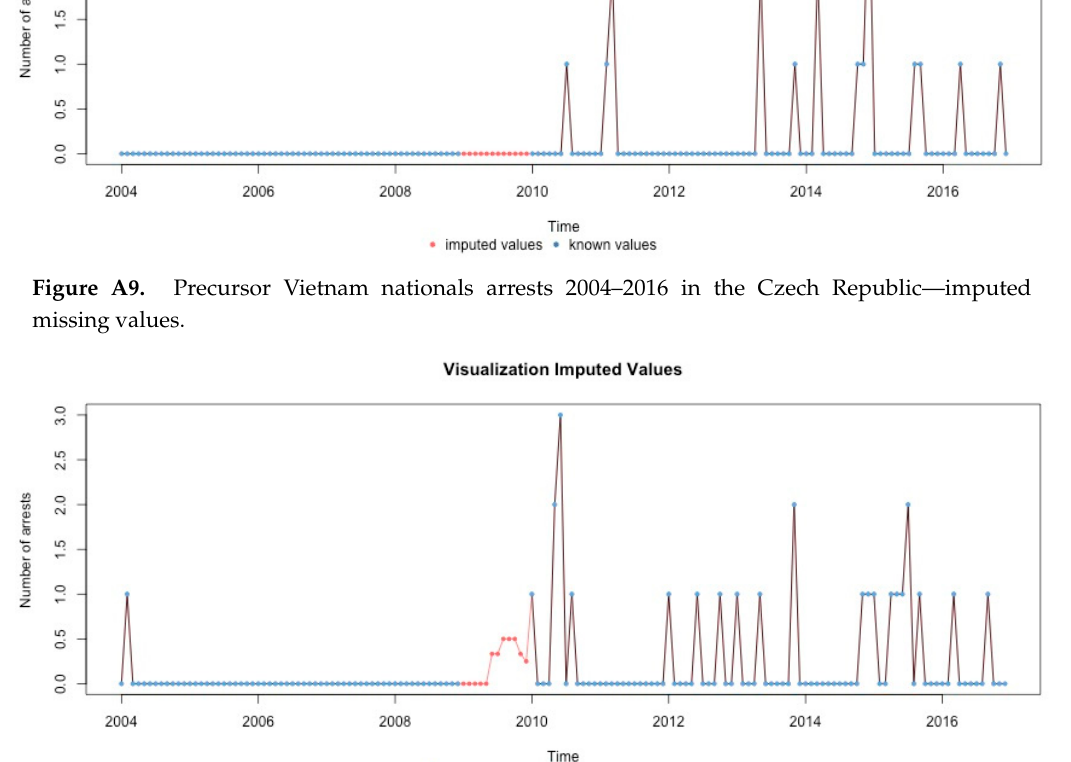
Figure A10. Precursor neighboring countries nationals arrests 2004–2016 in the Czech Republic – imputed missing values.